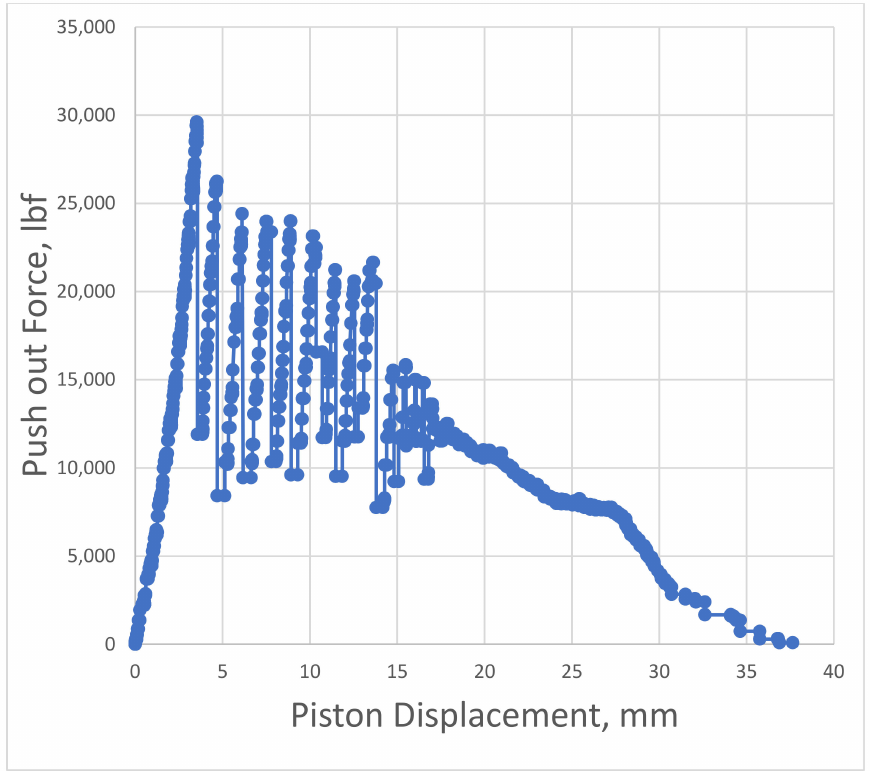
Figure 13. Push-out force versus piston displacement for sample cured for 7